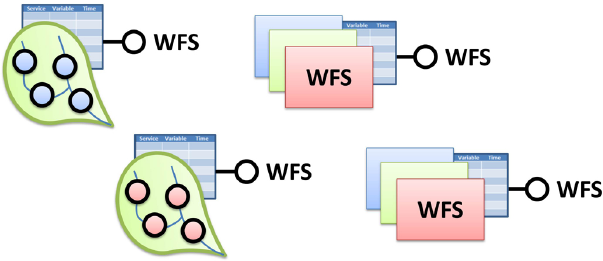
Fig. 6. CUAHSI-HIS services stack framework for time series and coverages.